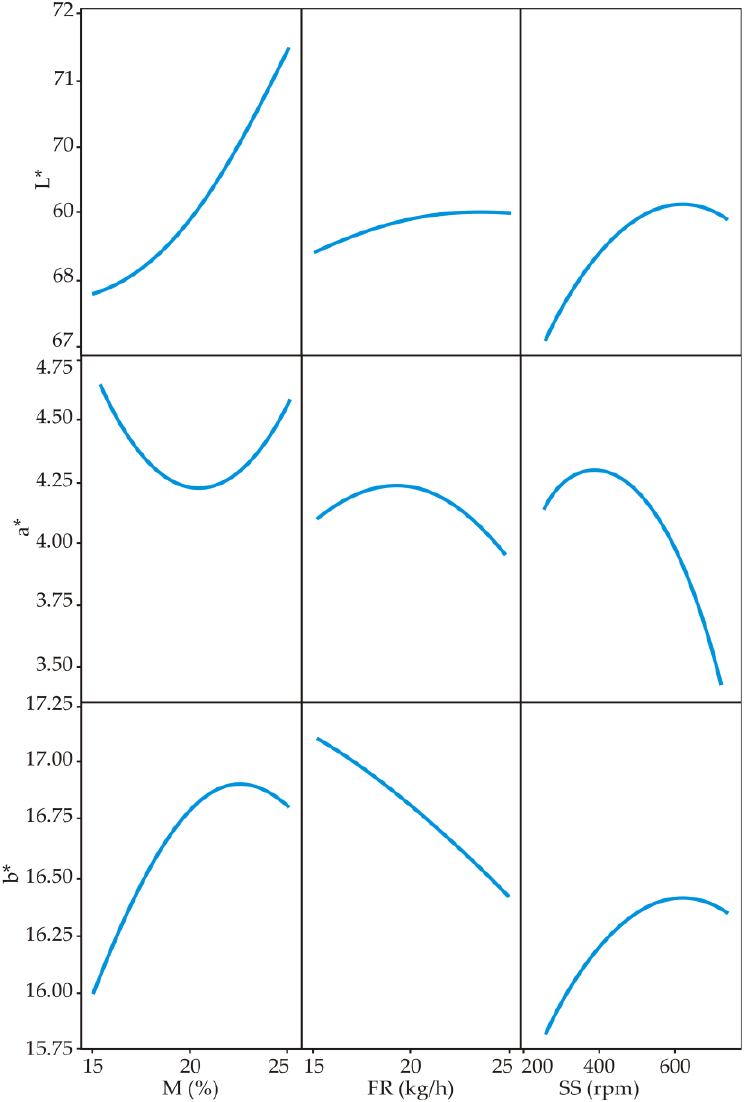
Figure 3. Influence of process parameters moisture (M), feed rate (FR) and screw speed (SS) on L*, a* and b*.